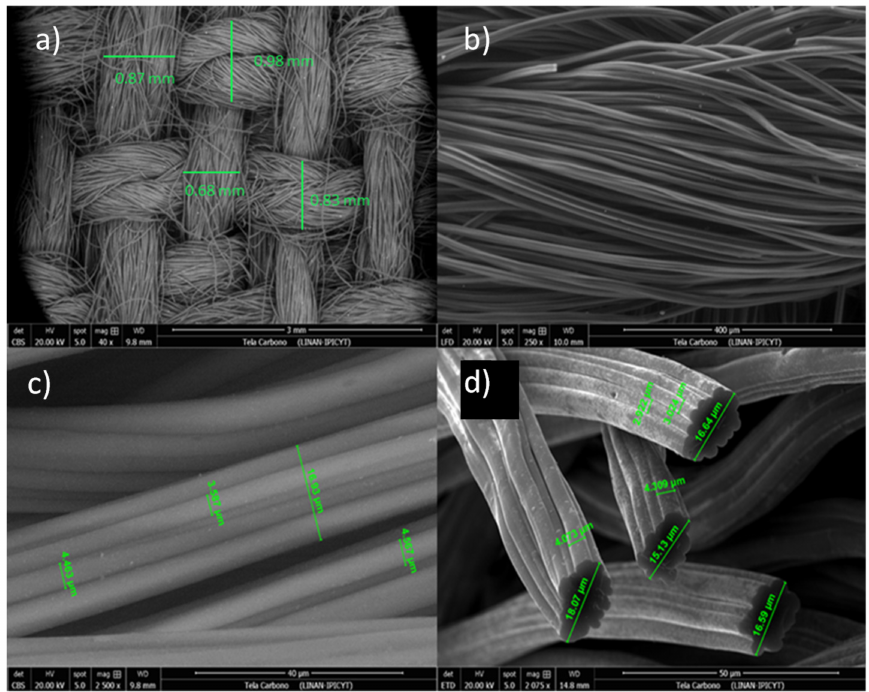
Figure 2. Microphotographs of the activated carbon cloth: ( a ) ACC ordered texture structure, ( b ) fiber bundles twined longwise, ( c , d ) magnified image of an ACC fiber.